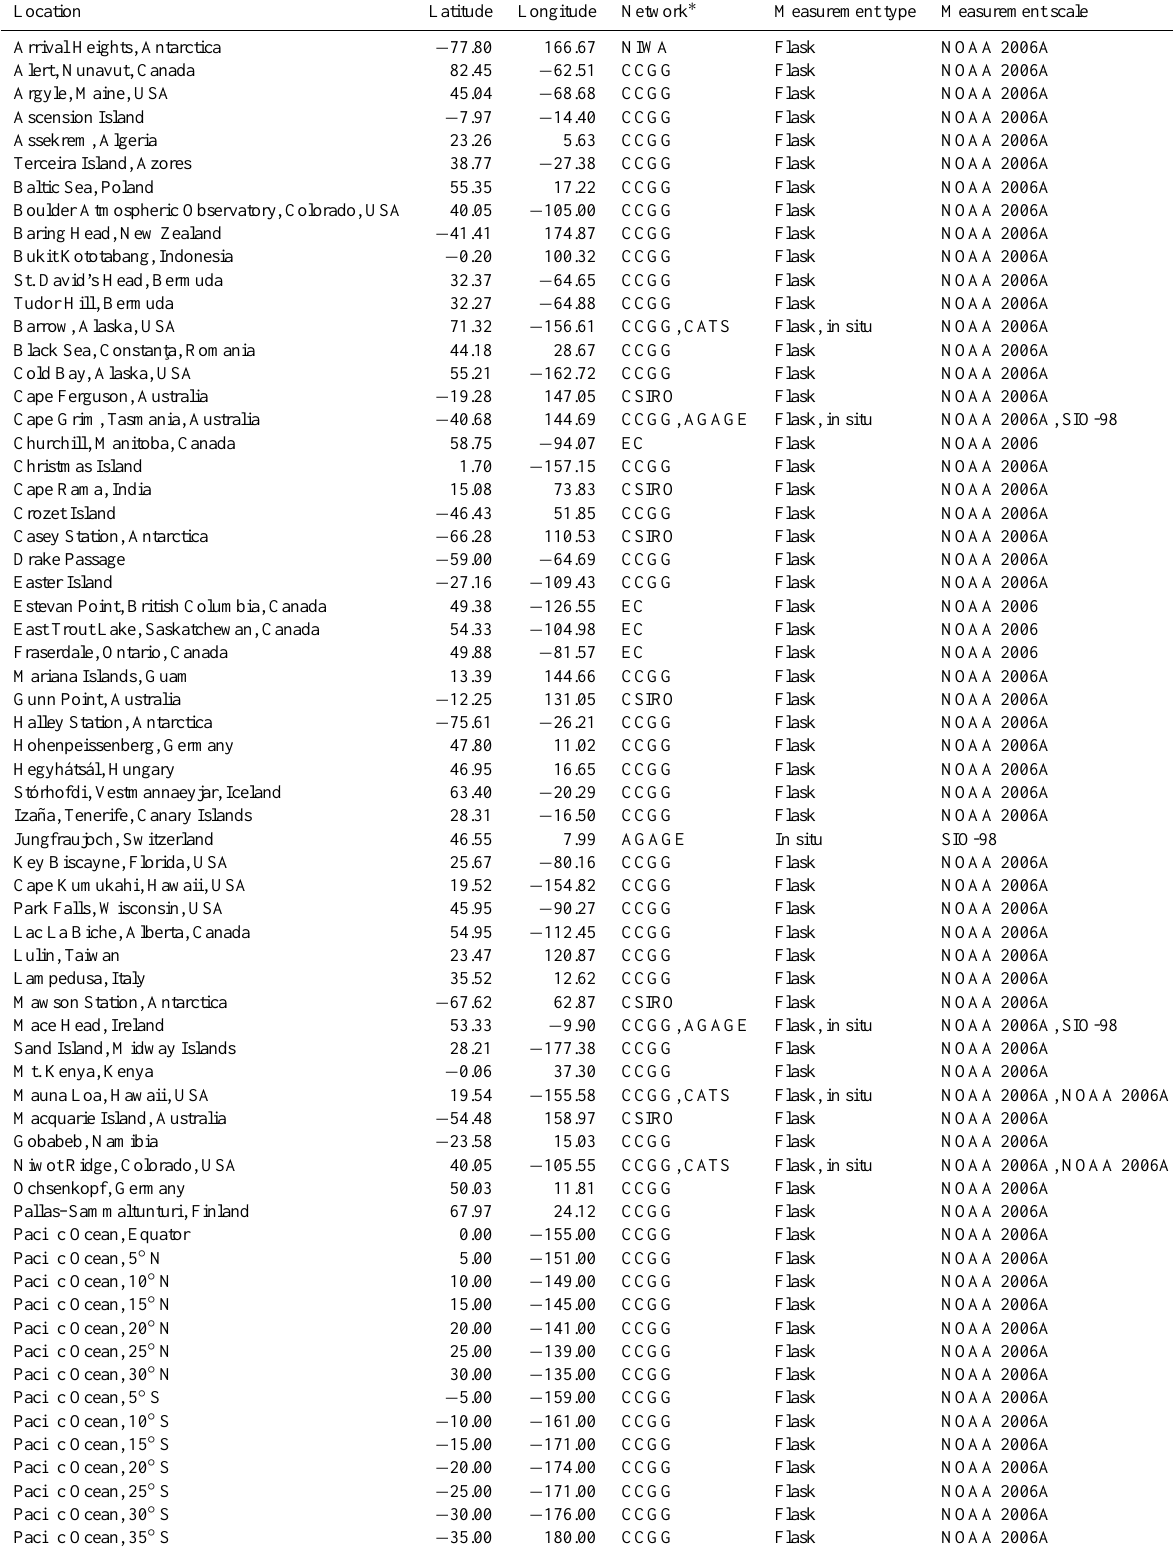
Table 2. Sites of surface flask and in situ N 2 O observations used in this study.